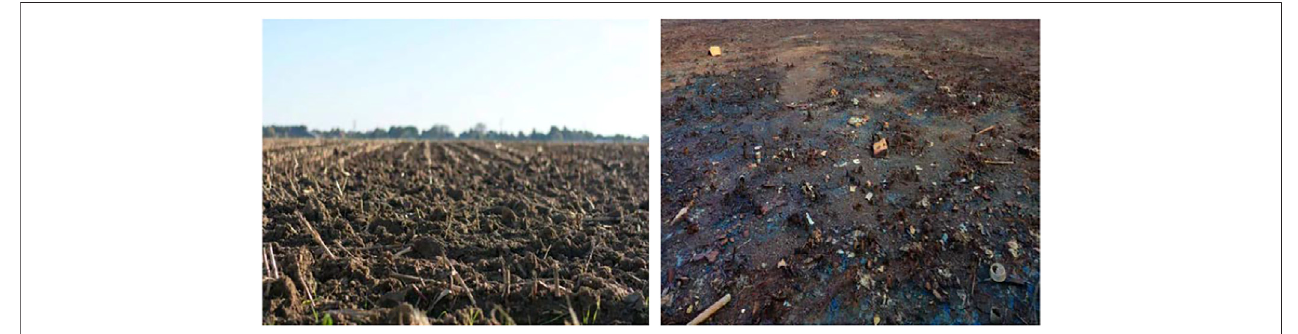
FIGURE 2 | Contaminated soil display